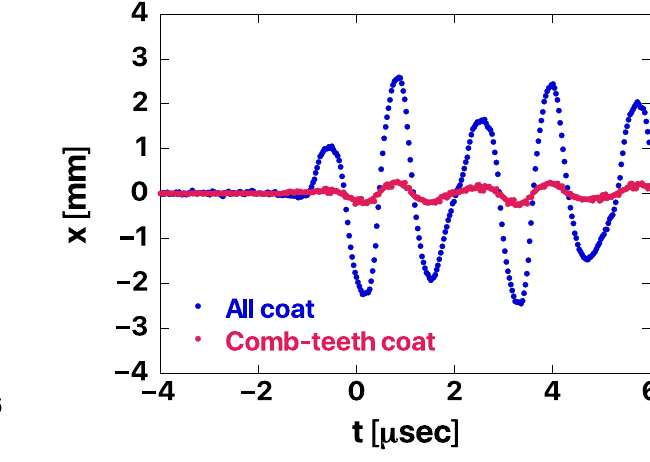
FIG. 20. Horizontal beam oscillation data for the simulated error kick by an eddy-current magnetic field.